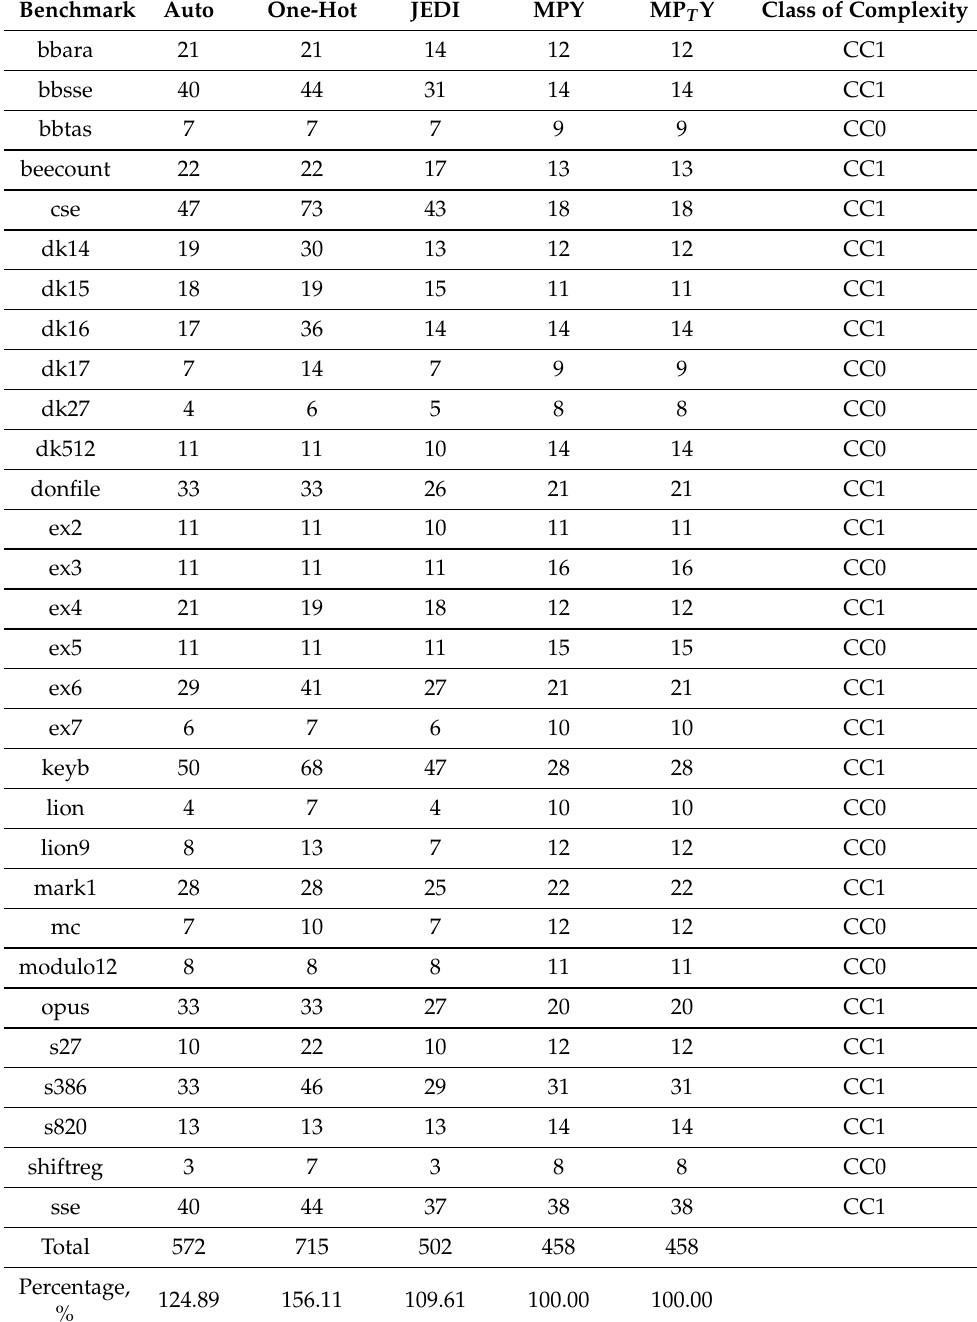
Table 8. Experimental results (the LUT counts for classes